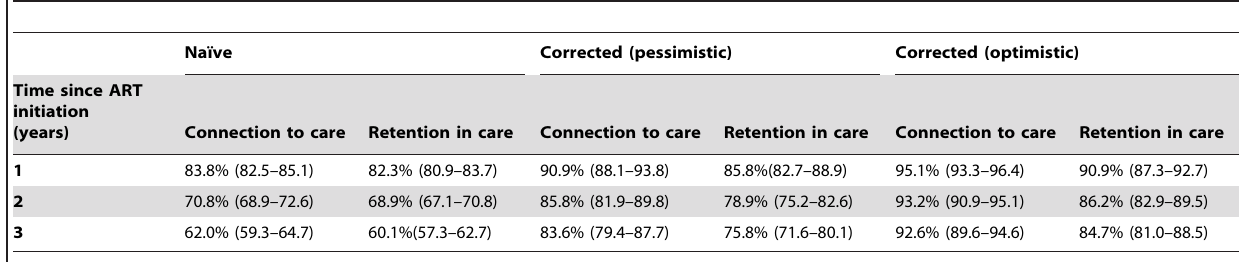
Table 2. Naı¨ve and corrected estimates of connection to care and retention in care with 95% confidence intervals.